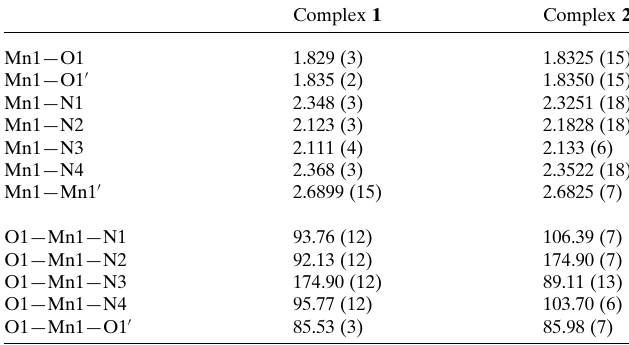
Table 1 Comparison of key bond lengths and angles (A˚ , (cid:5) ) for complexes 1 and 2 .